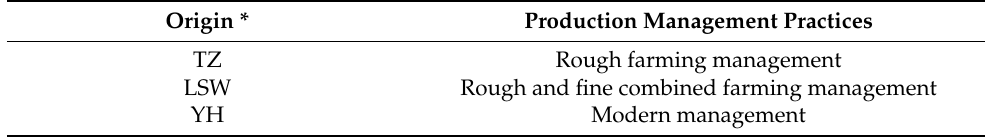
Table 1. Pear production management practices used in three different orchards. Origin * Production Management Practices TZ Rough farming management LSW Rough and fine combined farming management